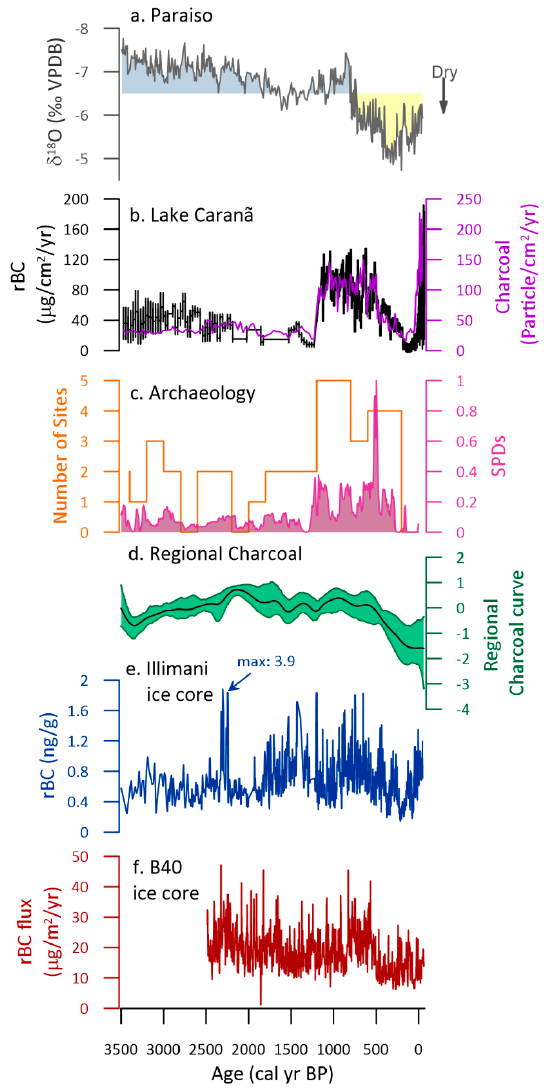
Figure 4. Comparison to regional archives. ( a ) Paraíso speleothem δ 18 O values as a proxy of regional hydroclimate from Wang et al. [54]. Increased δ 18 O values reflected increased aridity. ( b ) Macrocharcoal [41,42] (purple) and refractory black carbon (rBC) influx (black) from Lake Caranã. ( c ) Archaeology data calculated from the SPDs and site frequency data [42]. ( d ) RCC from the eastern Amazon [41]. ( e ) Illimani ice core rBC concentration (annual averages shown with a 5 year running median) from Osmont et al. [12]. (f) rBC flux from the B40 Antarctic ice core (shown are 7 year medians) from Arienzo et al. [11]. Note—the B40 ice core scale is μ g m − 2 yr − 1 .